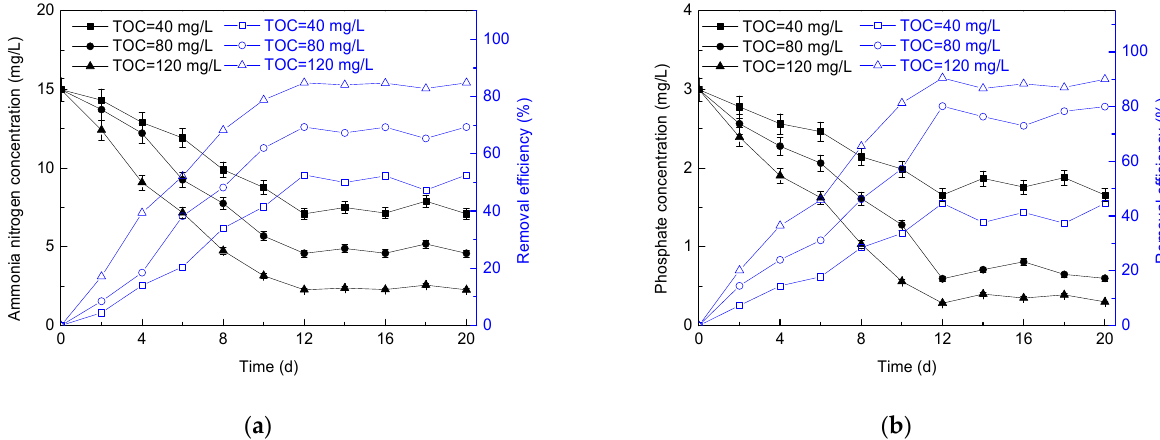
Figure 5. Changes in ammonia nitrogen ( a ) and phosphate ( b ) removal efficiency under different TOC concentrations.